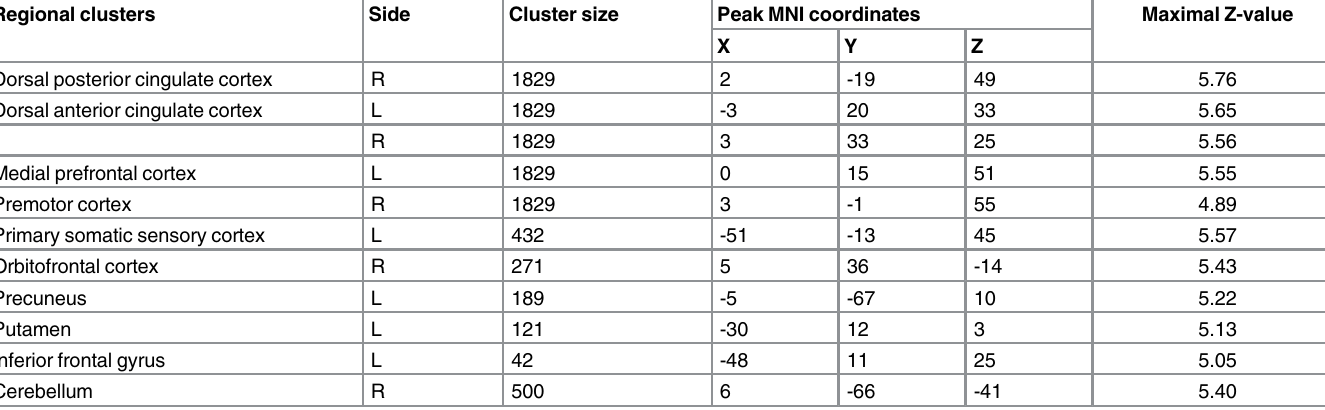
Table 2. Grey matter volume reduction in ADPs versus HCs (FWE corrected for multiple comparisons across the entire